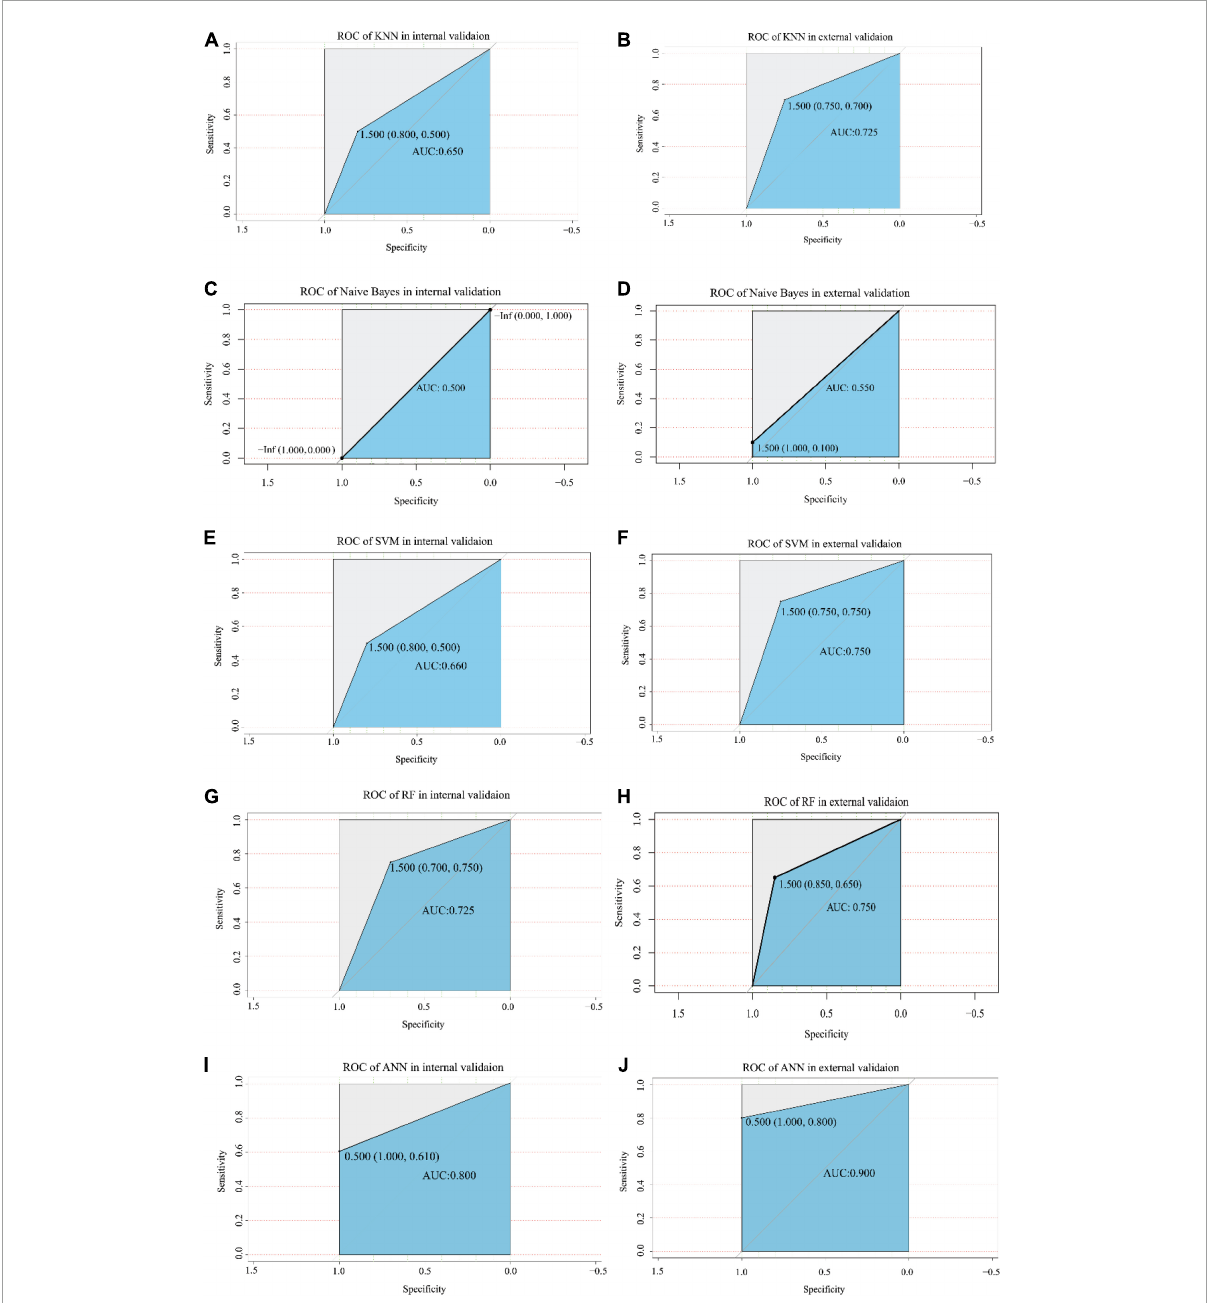
FIGURE5 The ROC analysis of each model in the internal validation and external validation cohorts. The X-axis and Y-axis represent specificity and sensitivity, respectively. The AUC values are indicated in the blue area, including KNN model (A,B) , Naive Bayes model (C,D) , SVM model (E,F) , RF model (G,H) , and ANN model (I,J) . The value of the cut-off point is shown at the inflection point. ROC, receiver operating characteristic; AUC, area under the curve; KNN, k-nearest neighbor; SVM, support vector machine; RF, random forest; ANN, artificial neural